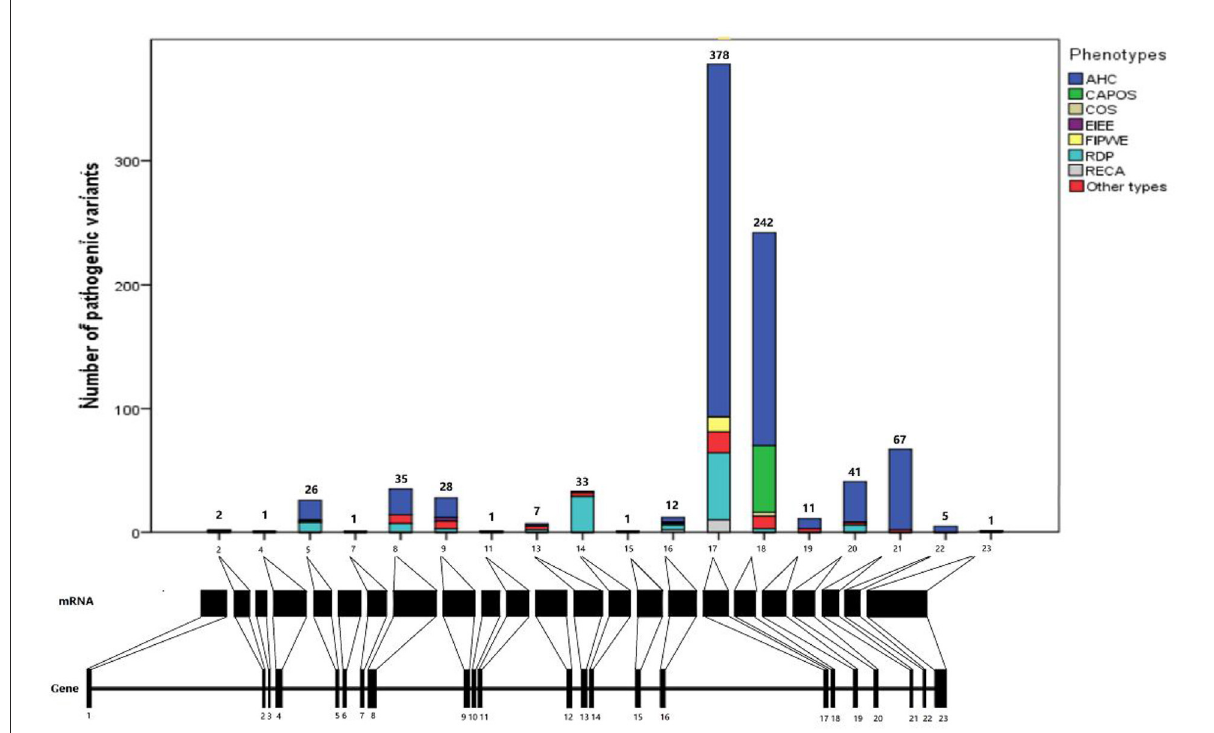
FIGURE2 Distribution of ATP1A3 mutations in gene and protein. AHC, alternating hemiplegia of childhood; CAPOS, cerebellar ataxia, areflexia, pes cavus, optic atrophy, and sensorineural hearing loss syndrome; epilepsy; COS, childhood-onset schizophrenia; EIEE, early infantile epileptic encephalopathy; FIPWE, fever-induced paroxysmal weakness and encephalopathy; RDP, rapid-onset dystonia-parkinsonism; RECA, relapsing encephalopathy with cerebellar ataxia.